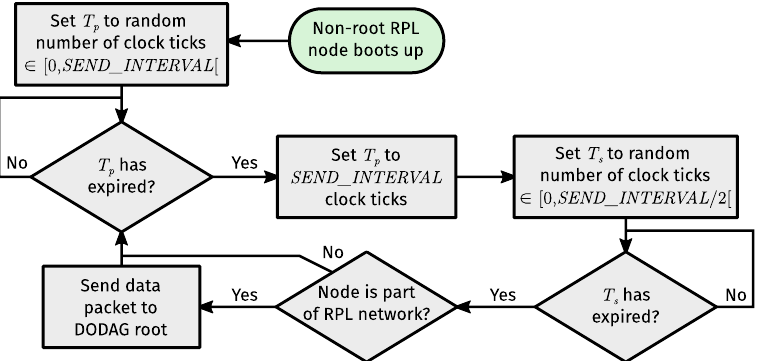
Figure 8. Flow of events related to pseudo-periodic data packet transmission (towards the root node) by non-root RPL nodes. Note that T p stands for “periodic timer”, T s stands for “send timer”, and SEND _ INTERVAL is the amount of clock ticks in a time-span of ten seconds.